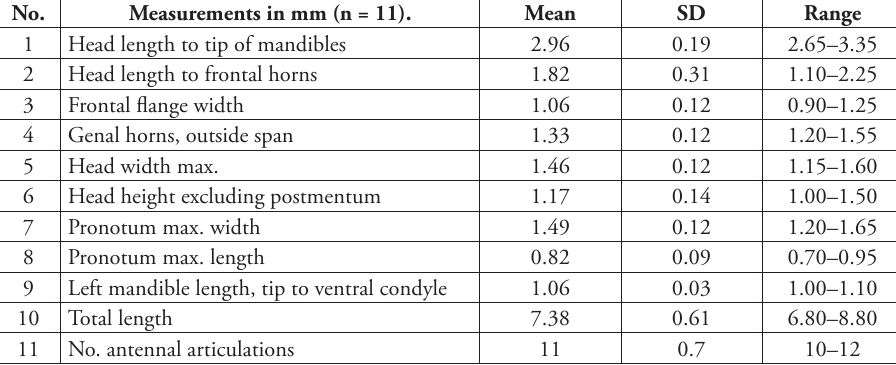
Table 6. Morphometrical measurements for soldiers of Proneotermes latifrons